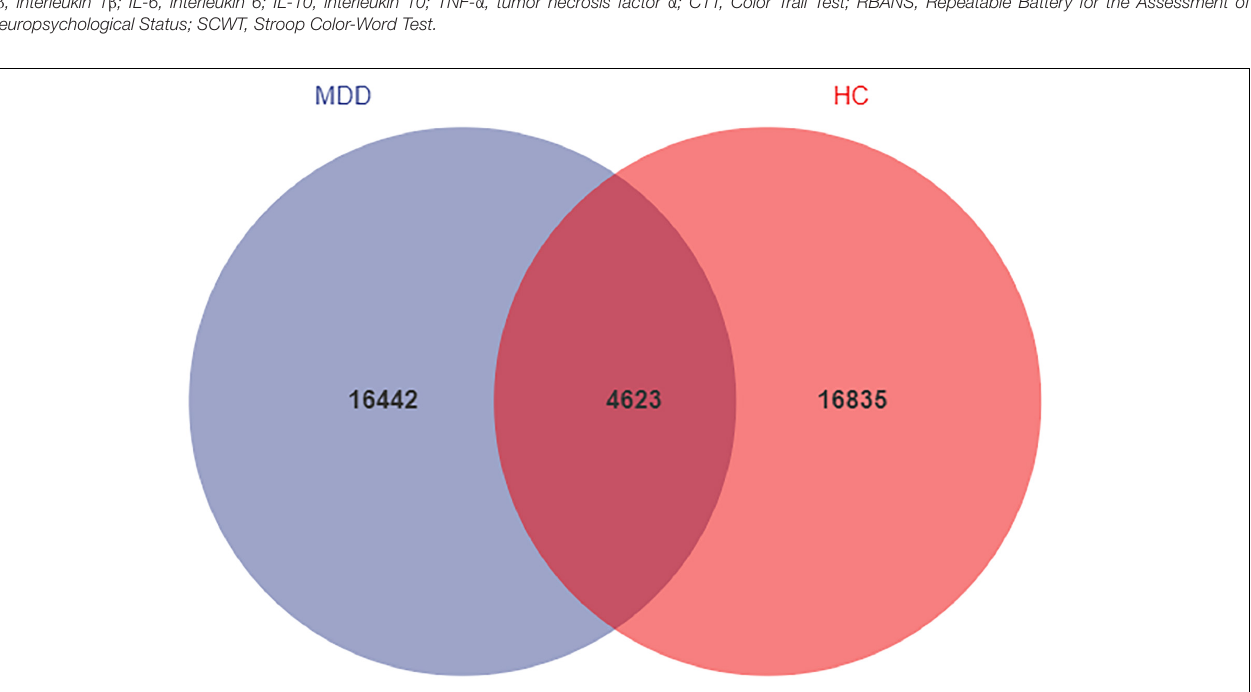
Frontiers in Neuroscience |